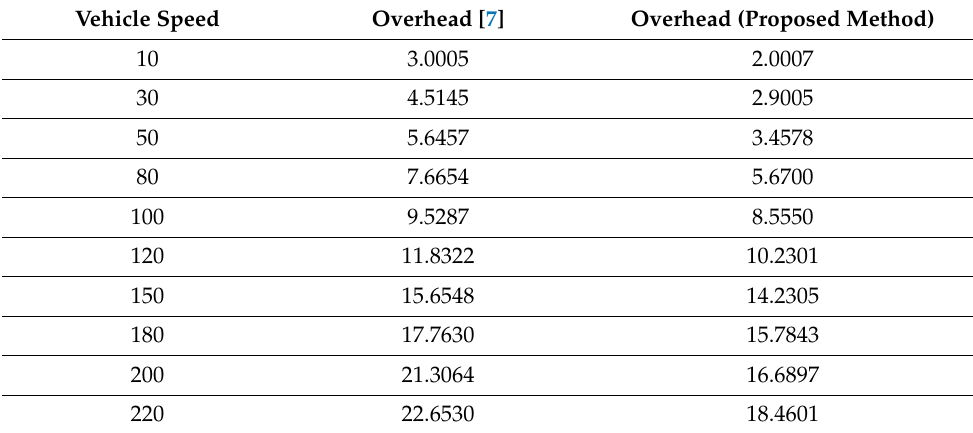
Table 4. Overhead.